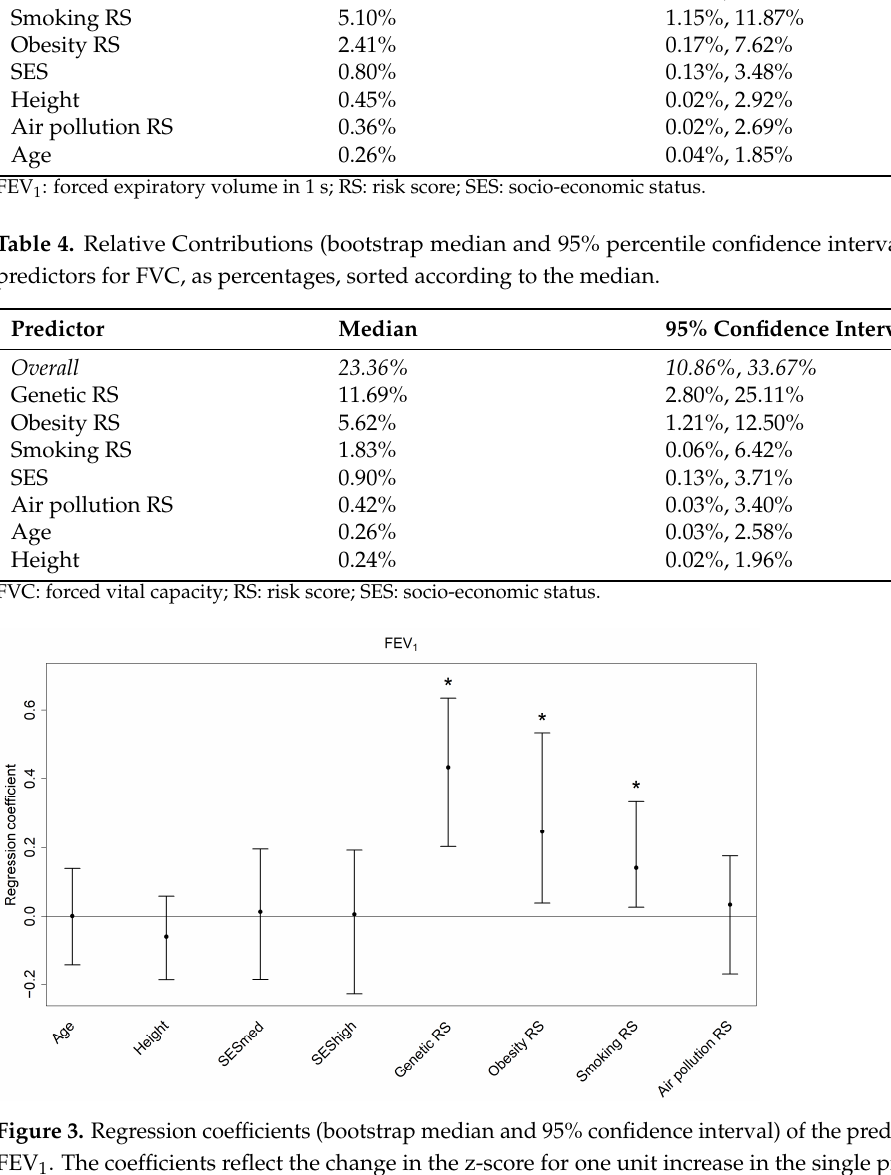
Figure 4. Regression coefficients (bootstrap median and 95% confidence interval) of the predictors for FVC. The coefficients reflect the change in the z-score for one unit increase in the single Predic- tors and one Interquartile Range Increase in the Risk Scores. FVC: forced vital capacity; RS: risk score; SESmed: medium socio-economic status (reference: low socio-economic status); SEShigh: high socio-economic status (reference: low socio-economic status); * p < 0.05.